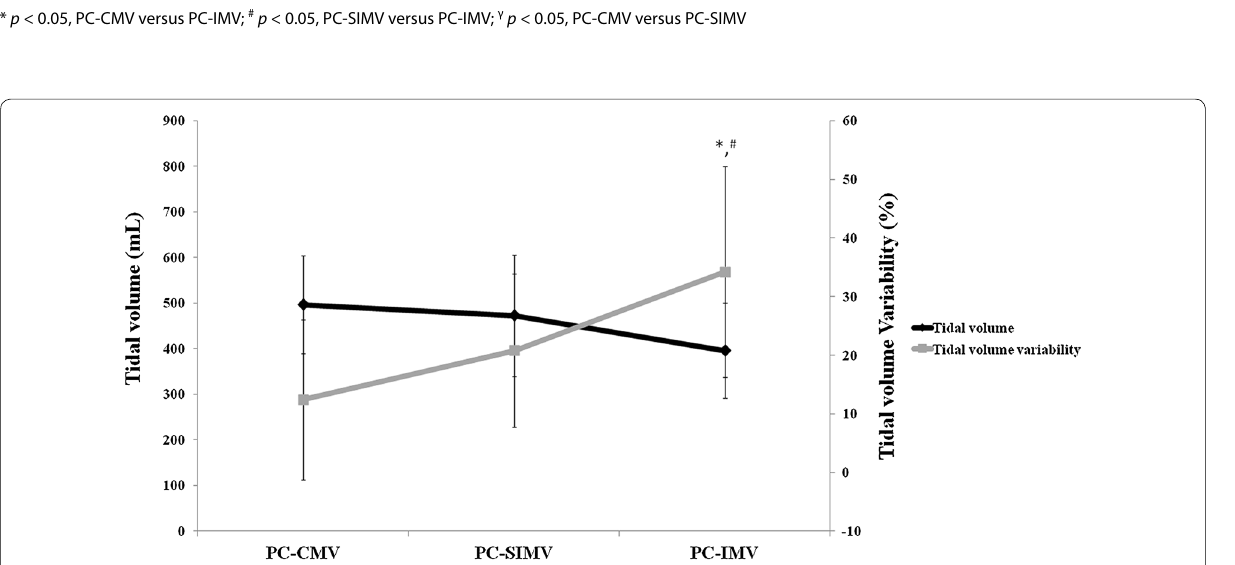
Fig. 2 Tidal volume and tidal volume variability during fully, partially, and non inspiratory synchronized pressure‑controlled modes (* p < 0.05; PC‑IMV vs PC‑CMV and # p < 0.05; PC‑IMV vs PC‑SIMV). PC-CMV pressure‑controlled continuous mandatory ventilation, PC-SIMV pressure‑controlled synchronized intermittent mandatory ventilation, PC-IMV pressure‑controlled intermittent mandatory